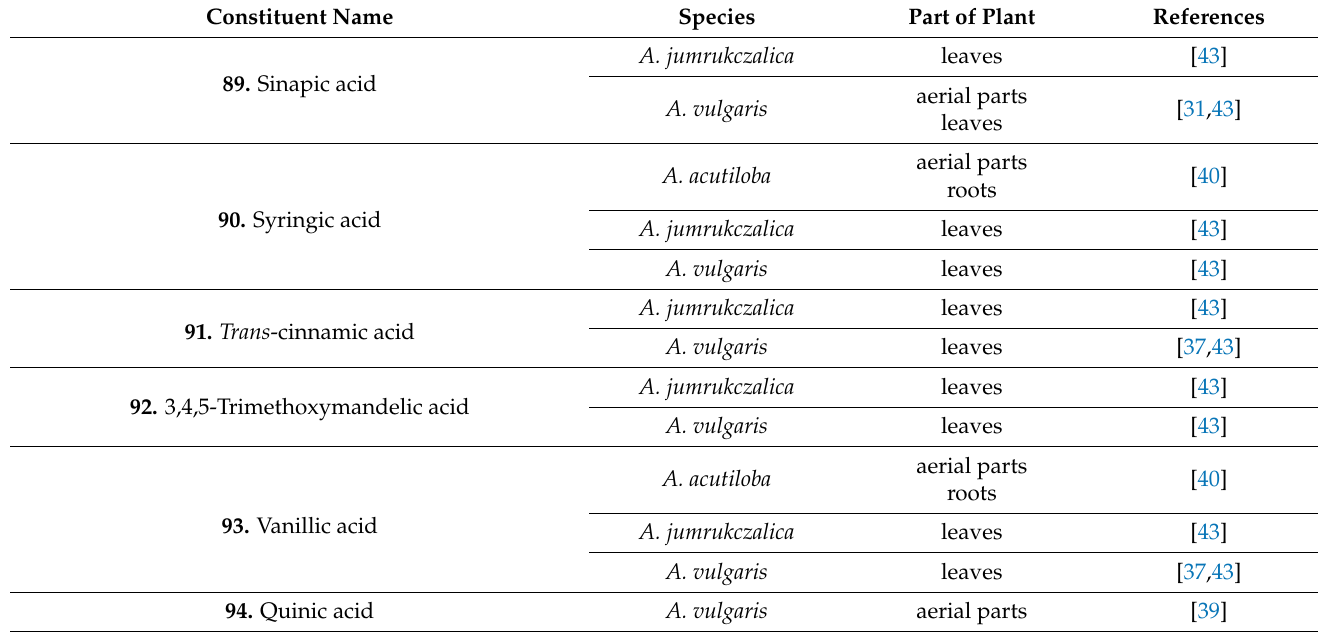
The plant tannins are a unique group of phenolics of relatively high molecular weight with the ability to complex strongly with carbohydrates and proteins. In higher plants, tannins consist of two major groups of metabolites: the hydrolysable tannins and condensed tannins [17]. Alchemilla species as members of Rosaceae family also produce, apart from flavonoids, tannins.